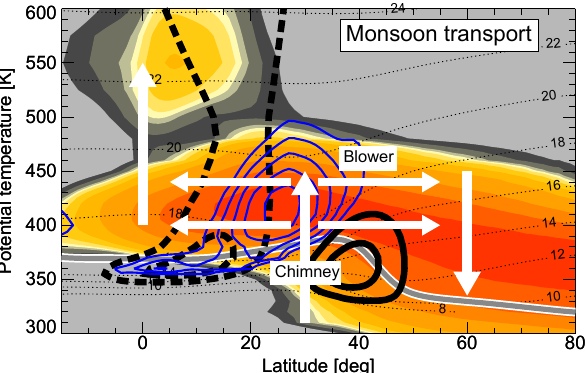
Figure 5. Schematic of pollution transport from the monsoon into the stratosphere. Color shading shows zonal mean anticyclone air mass fraction (from climatological October values below about 500K, climatological June values above), with white arrows illus- trating the dominant transport pathways. Note the nonlinear color scale for the tracer mixing ratios to highlight the patterns (contour value 0, 0.001, 0.002, 1.4, 1.401, 1.402, 1.403, 1.404, 1.6, 1.8, 1.9, 2, 2.2, 2.6, 3.5, 6, 9, 13%). Black contours show zonal wind ( ± 15, 25ms − 1 solid/dashed), blue contours diabatic heating rates (from 1Kday − 1 increasing in 0.2Kday − 1 steps), thin black geopotential height, and thick grey line the (WMO) tropopause, all from ERA– Interim for June–August and zonally averaged over the monsoon region (40–100 ◦